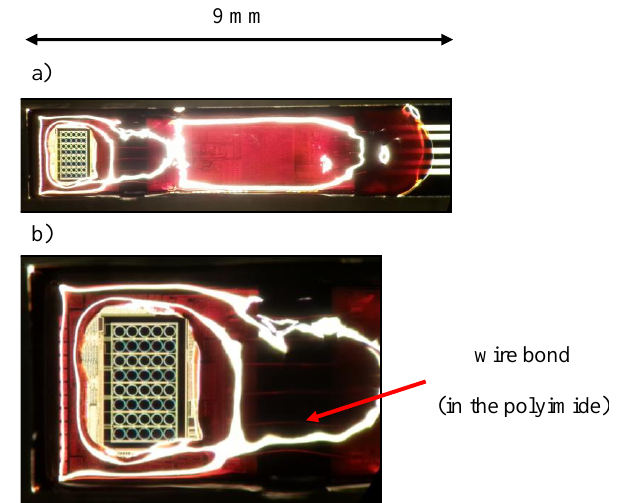
Figure 8. Casting of the entire sensor module before the ALD pas- sivation. (b) Detailed image of the pressure sensor chip after the